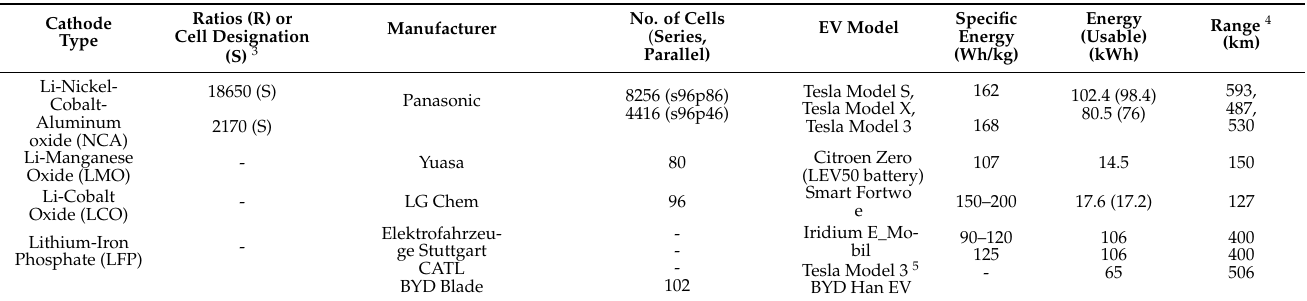
Table 2. Main cathodes, excluding Lithium Nickel-Manganese-Cobalt (NMC), used in EVs. and their main characteristics [28,32–39]. Also available on the ALBATTS project website [40].